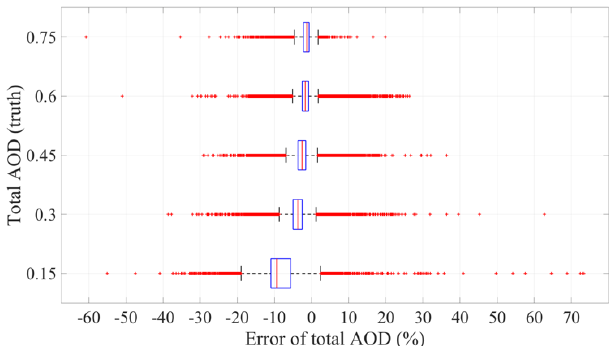
Figure 10. Boxplots of total AOD prediction errors for each true total AOD value. The box central mark indicates the median, and the bottom and top edges of the box indicate the 25th and 75th per- centiles, respectively. The whiskers extend to the most extreme data points not considered outliers, and the outliers are plotted individu- ally using the “ + ”